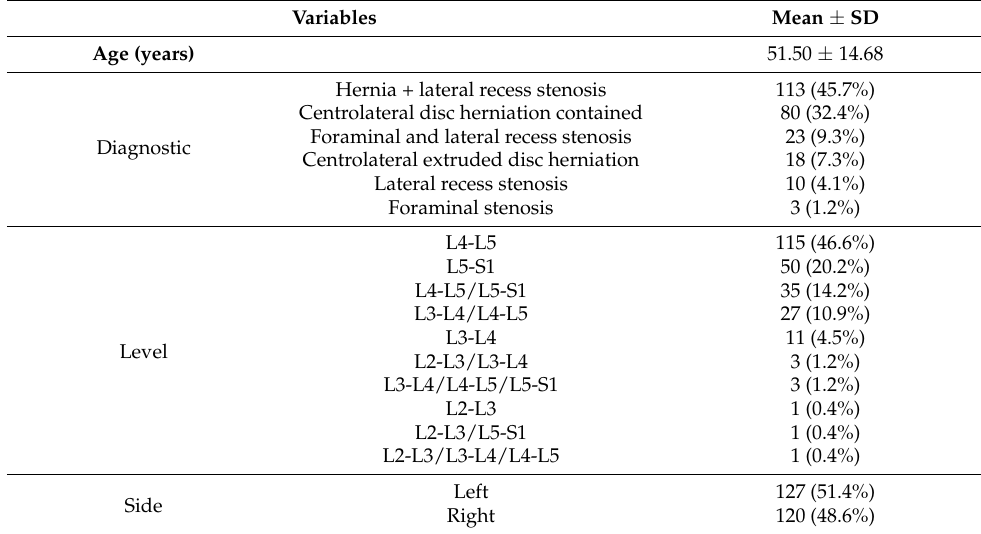
Table 1. Descriptive analyses of the sample characterization variables.